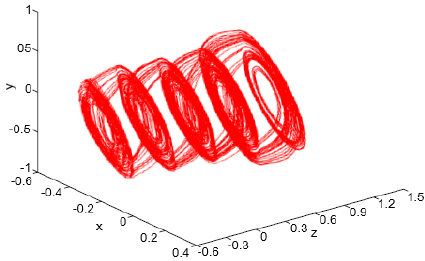
Figure 5. A chaotic attractor with five scrolls. The quintuple-scroll attractor is generated by (2.2) via the series switching technique with the parameter values